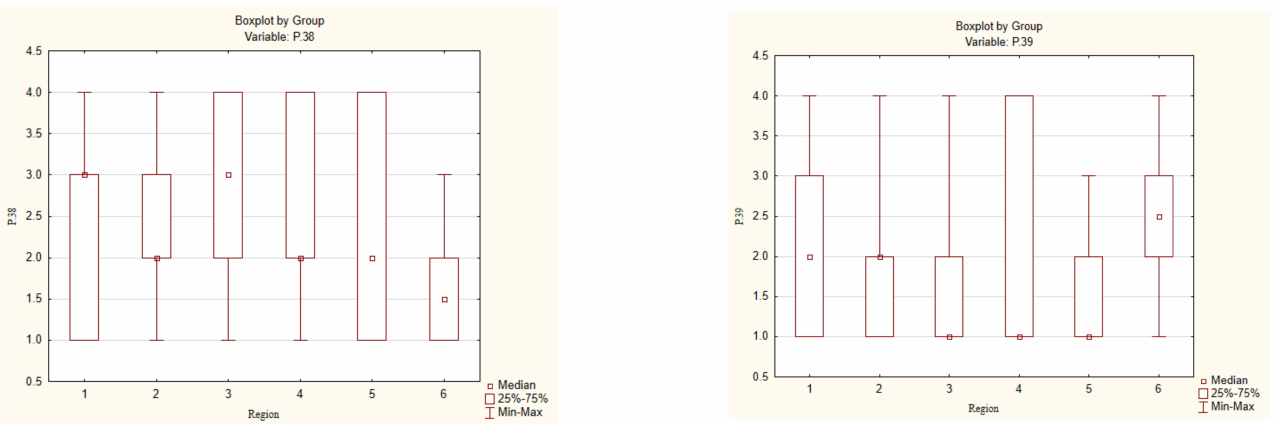
Figure 13. Box and whisker charts by practices P38 (Buying organic products), P39 (Buying recycled goods), from category “Shopping”.